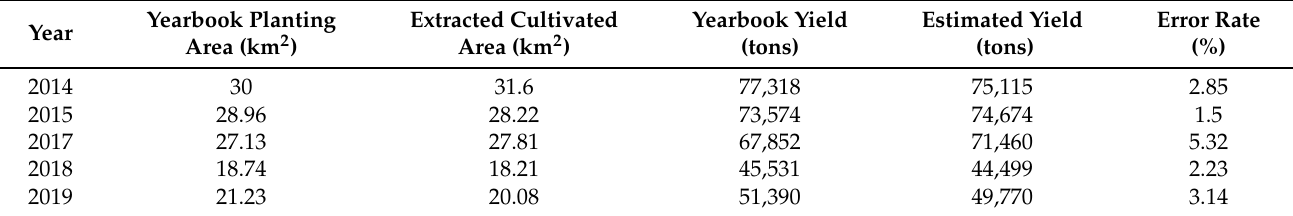
Table 5. Comparison of estimated yield with statistical yearbook data in Wuxue